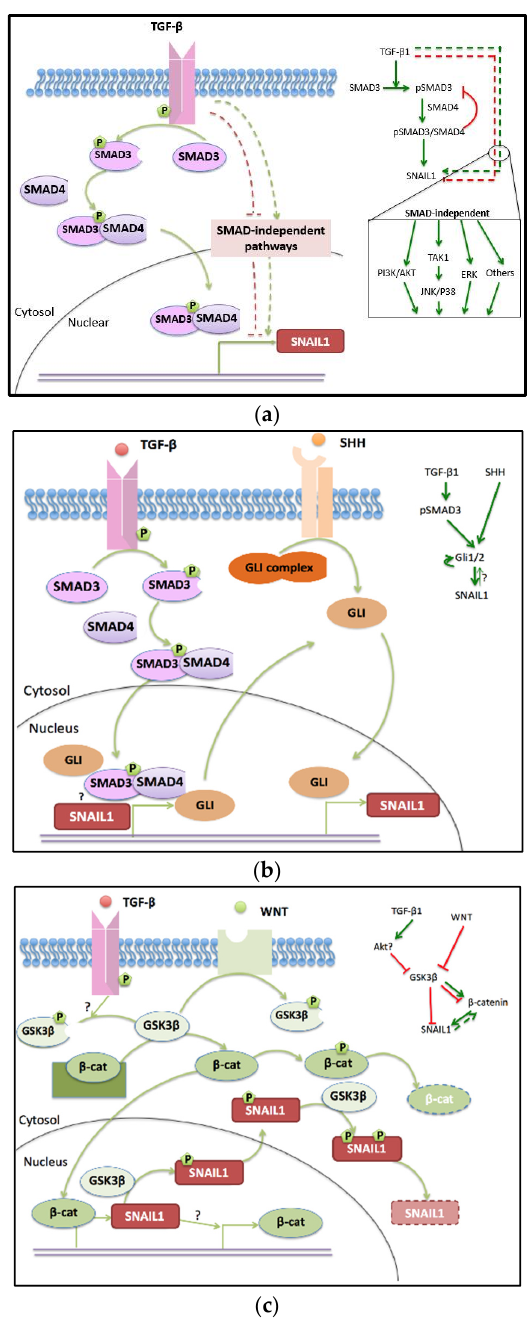
Figure 2. Crosstalk among the TGF ‐β ( a , proteins in pink), SHH ( b , proteins in orange), and WNT ( c , proteins in green) signaling pathways converging to the core regulation unit. In the inserted regulation networks, point arrows represent activation, blunt ones represent inhibition, and dashed lines represent indirect links.